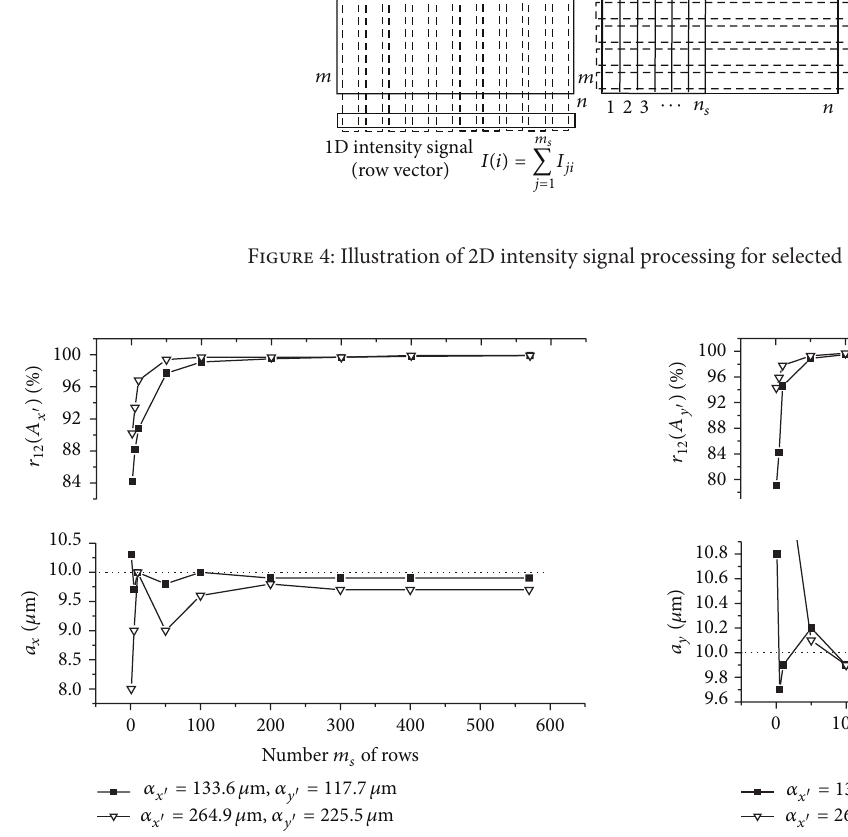
Figure 5: Resultant values of the evaluated object’s translation component 𝑎 𝑥 aswellasthemaximum 𝑟 12 (𝐴 𝑥 󸀠 ) ofthe1Dnormalized cross-correlation function 𝑟 12 of the intensity signals 𝐼 1 and 𝐼 2 as a function of number 𝑚 𝑠 of rows of the area used for the 2D intensity signal processing. The object is translated by 𝑎 𝑥 = 𝑎 𝑦 = 10 𝜇 m.